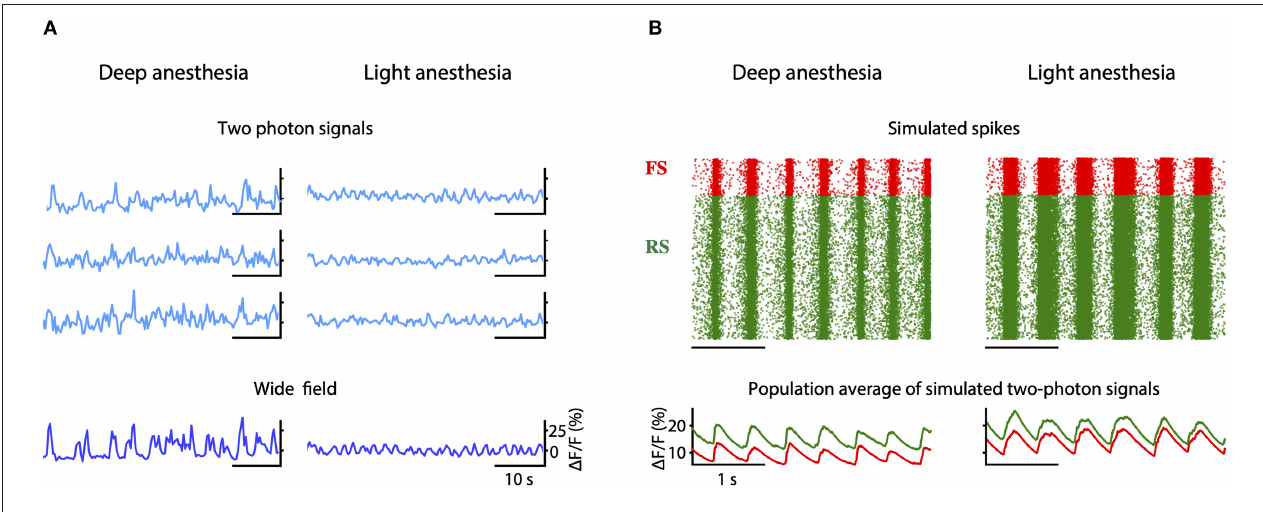
FIGURE 10 | Simulation of peri-stroke local network oscillations: experiments and models. (A) Fluorescence traces obtained from three example cells (two-photon signals) and from the entire field-of-view (wide field signals) recorded in mice under deep and light anesthesia. (B) Raster plot of the spikes (top) and averaged two-photon calcium signals (bottom) computed for the inhibitory (FS, in red) and excitatory (RS, in green) populations in a model of deep or light